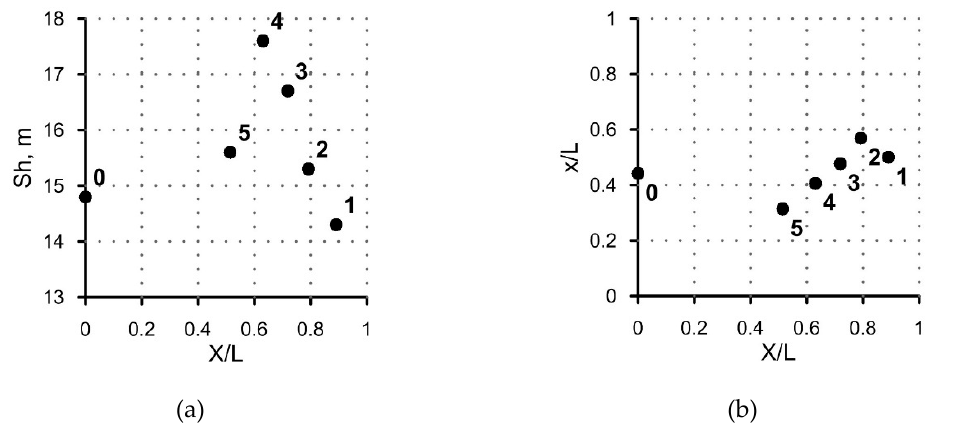
Figure 5. ( a ) Shoreline regression (Sh, m) and ( b ) distance of seaward sediment transport, in terms of wavelength (x/L) independence of the initial bar location (X/L). X is the distance between the bar crest and the shoreline, x is the distance of the maximum amounts of sediments that are transported away from the shore, L is the wavelength calculated for deep-water conditions Compared to the profile without a bar, the profile with the furthest bar location (the relative